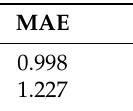
Table 1. APMNet’s